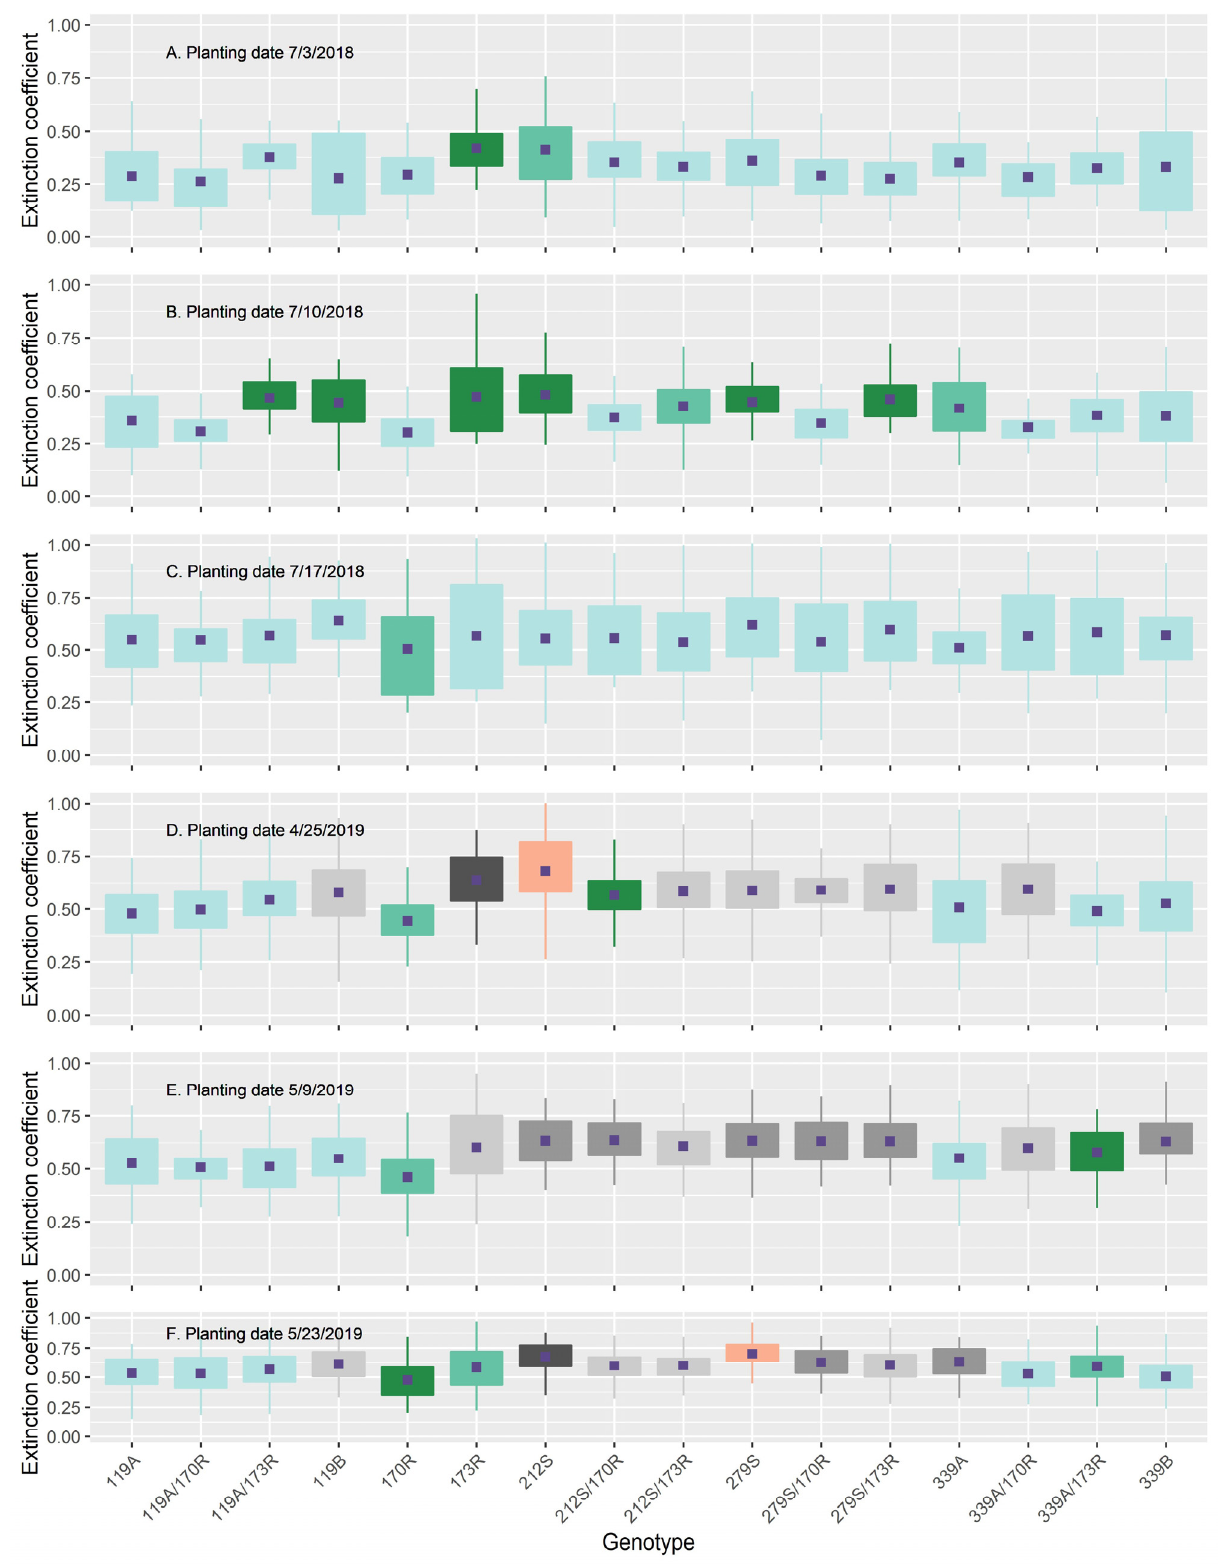
Figure 10. Light extinction coefficients and multiple comparisons for different rice genotypes: ( A ) Planting date 7/3/2018; ( B ) Planting date 7/10/2018; ( C ) Planting date 7/17/2018; ( D ) Planting date 4/25/2019; ( E ) Planting date 5/9/2019; ( F ) Planting date 5/23/2019. Genotypes with the same color in a plot are not significantly different from each other at 0.05 with Tukey’s HSD multiple comparison test.